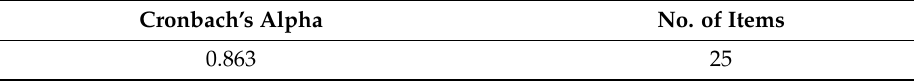
Table 2. Cronbach’s Alpha Reliability